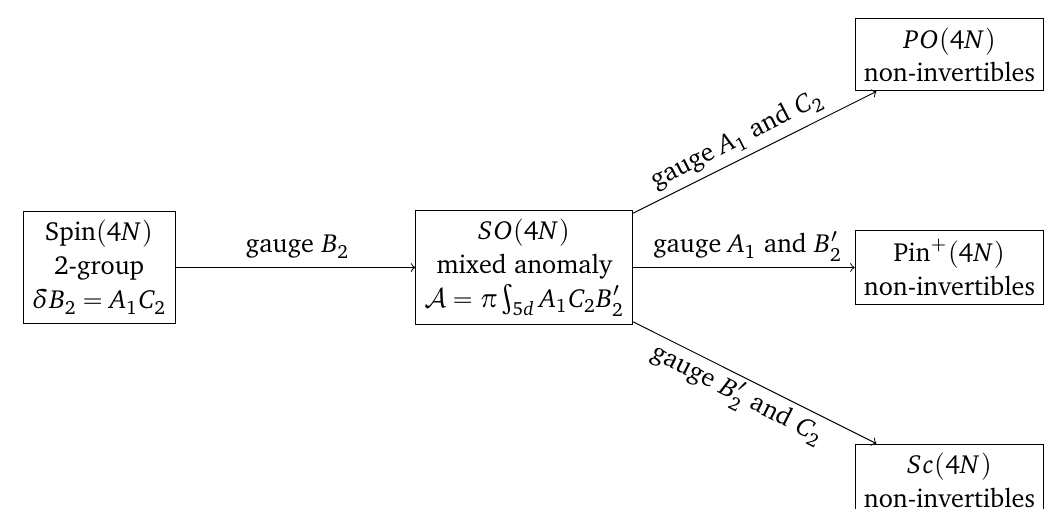
Figure 27: Overview of the theories with non-invertible symmetries that we can con- struct from gauging the 2-group in the Spin p 4 N q theory in